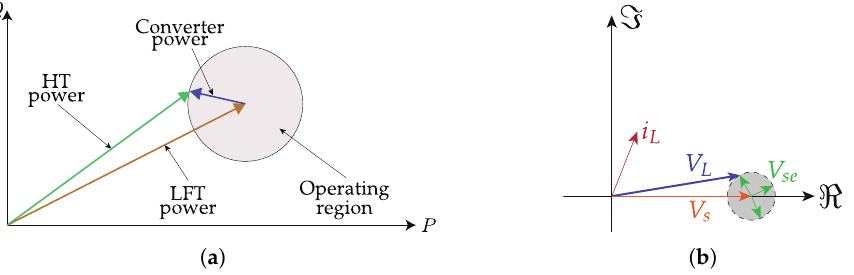
Figure 13. Operating region of HDTs whose power converters are capable of injecting active and re- active power. ( a ) PQ operating region. ( b ) Complex plane operating region for voltage